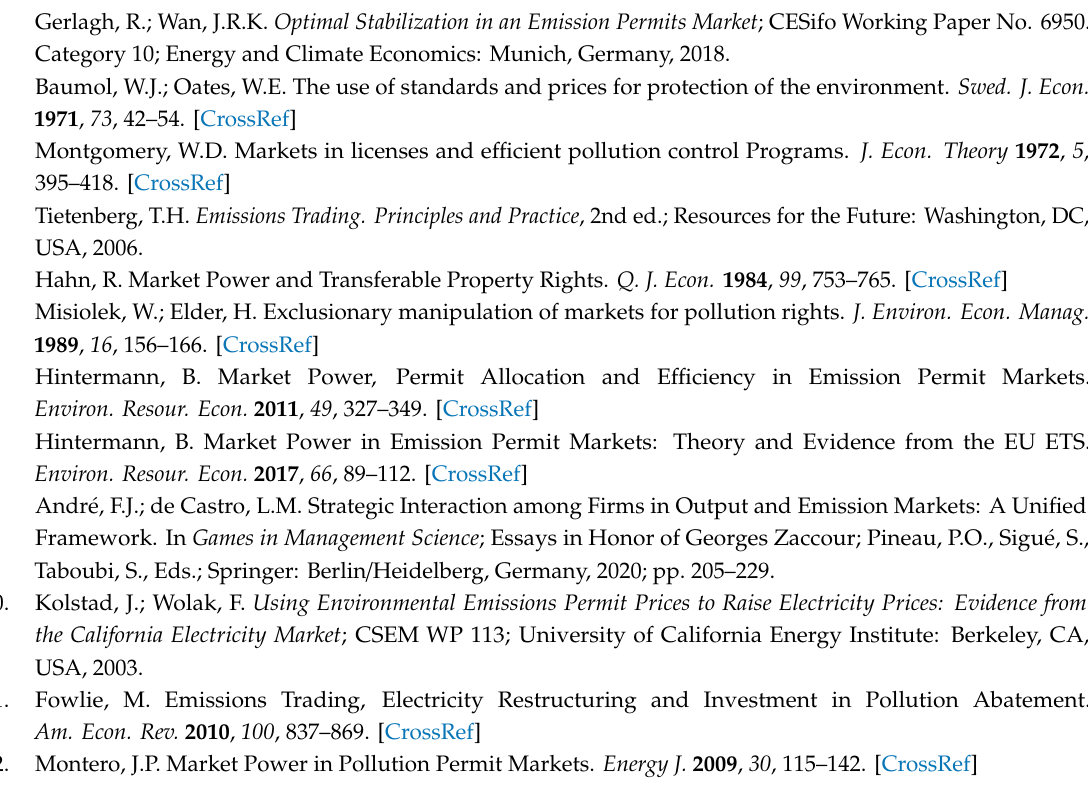
represents the constraint that must be satisfied for the abatement of firm 1 to be positive in Cournot and Stackelberg-2 models. The constraints that are redundant are not displayed in the graph. The blue dashed area represents the region for which all the interior solution conditions hold for all three models, at the same time. The black dashed lines show that imposing 0.2 ≤ S ≤ 0.5 is a su ffi cient (not necessary) condition that guarantees that all the solutions are interior for all three